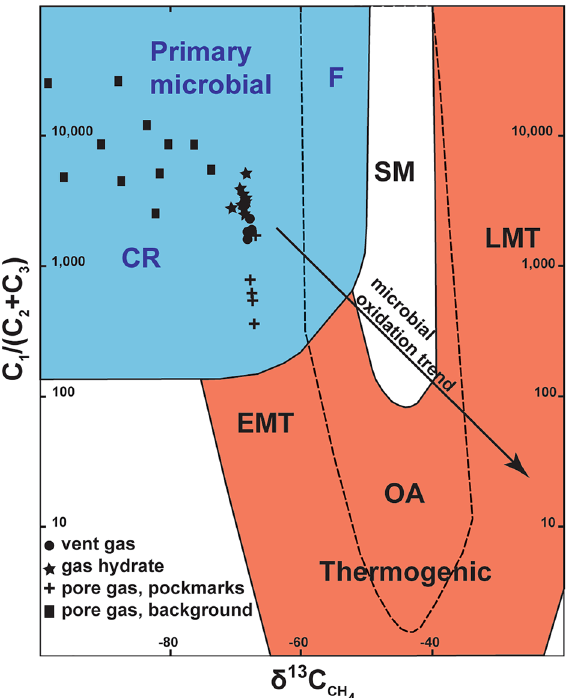
Figure 7. Diagram showing the relationship between carbon stable isotope composition (δ 13 C) of methane and the methane/ethane + propane ratio (C1/(C2 + C3)) of different gas samples analysed in this study. All samples indicate a primary microbial origin for methane. Gas hydrate and vent gas samples show a deviation from pore gas samples in pockmarks possibly owing to gas hydrate precipitation and anaerobic oxidation of methane, while background samples show a trend typical of microbial oxidation. Detectable quantities of the 14 C isotope were found in gas samples in sediment pores, but not in gas hydrates and vent gas. The genetic fields (CR = CO 2 reduction, F = methyl-type fermentation, SM = secondary microbial, EMT = early mature thermogenic gas, OA = oil-associated thermogenic gas, and LMT = late mature thermogenic gas) are from a global compilation of revised genetic diagrams for natural gases 65